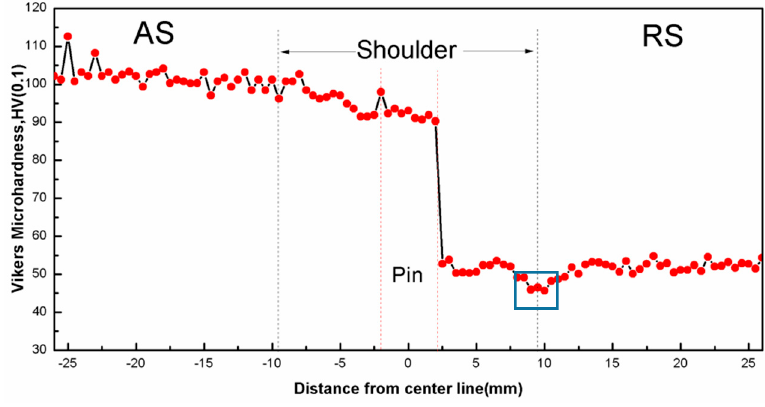
Figure 9. Microhardness distribution of the dissimilar joint.